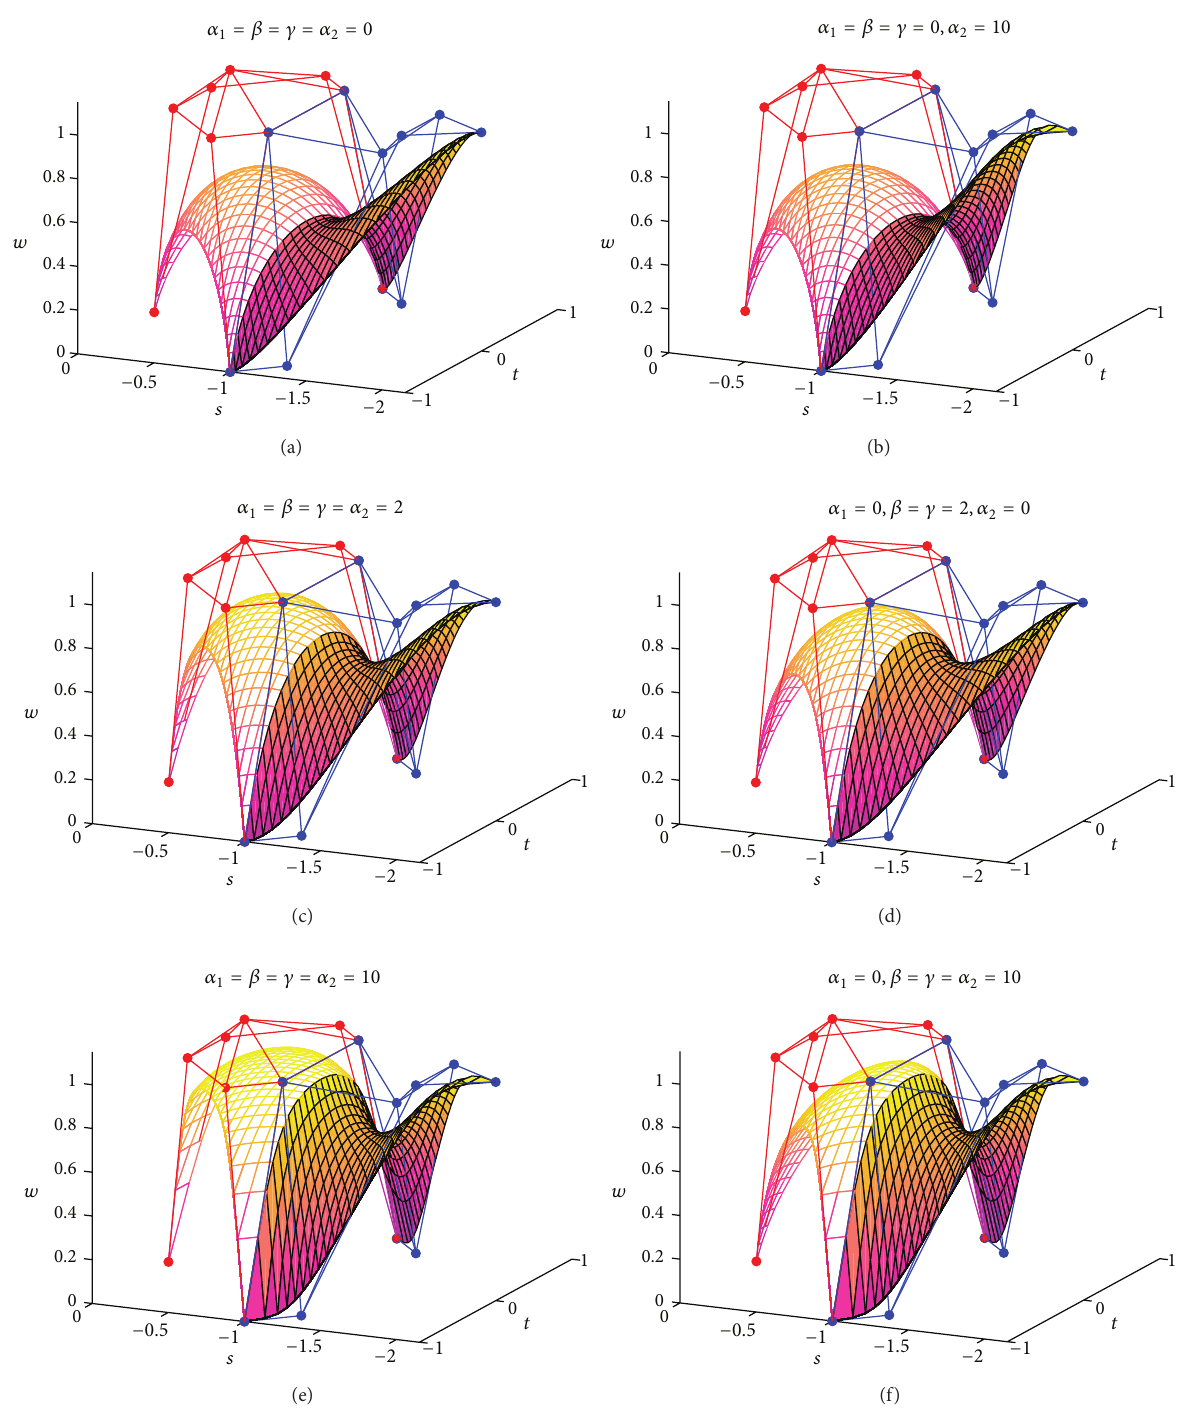
Figure 12: 𝐺 1 continuous surfaces with different shape